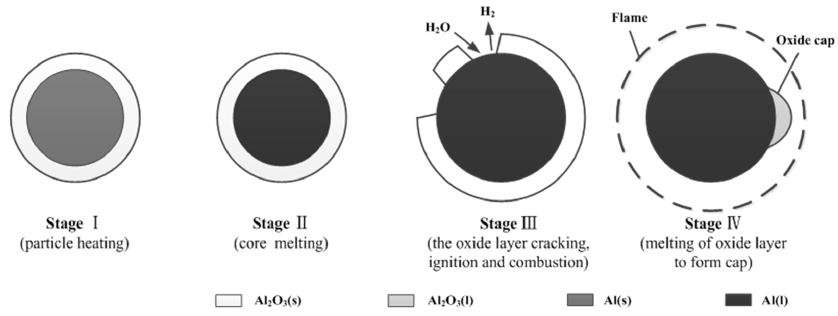
Figure 3. Configuration showing an Al particle ignition and combustion procedure.